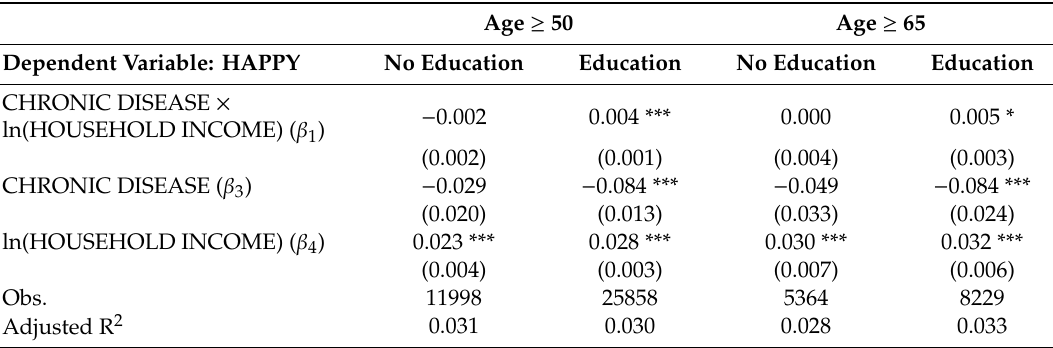
Table 7. By education.